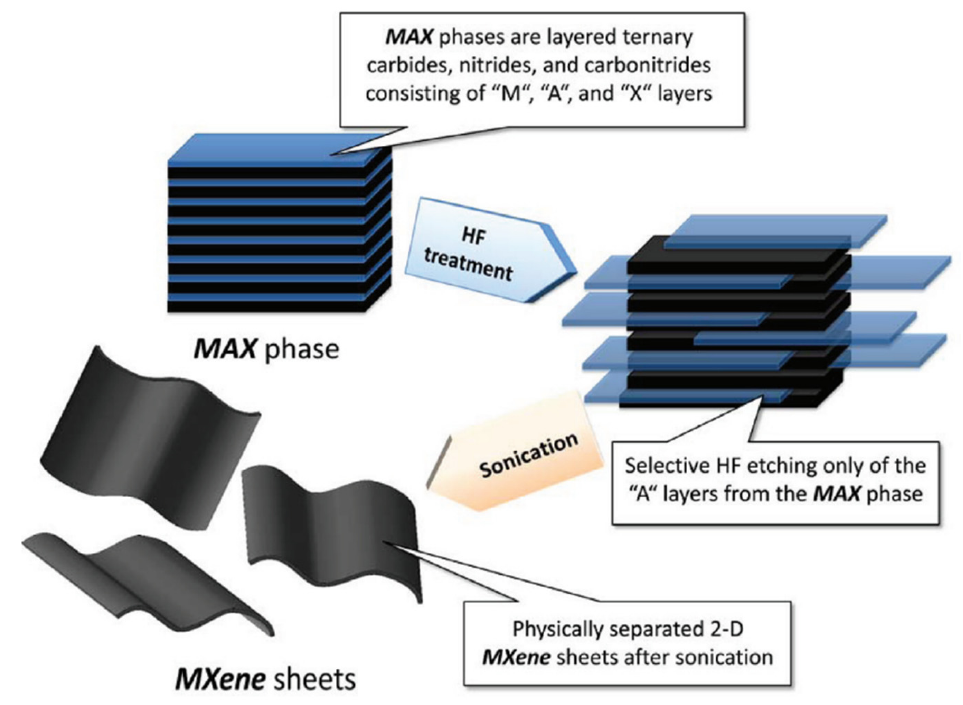
Figure 5. Formation of MXenes by etching and exfoliation of MAX phases. Reprinted with permission from [61]. Copyright © 2012 American Chemical Society.